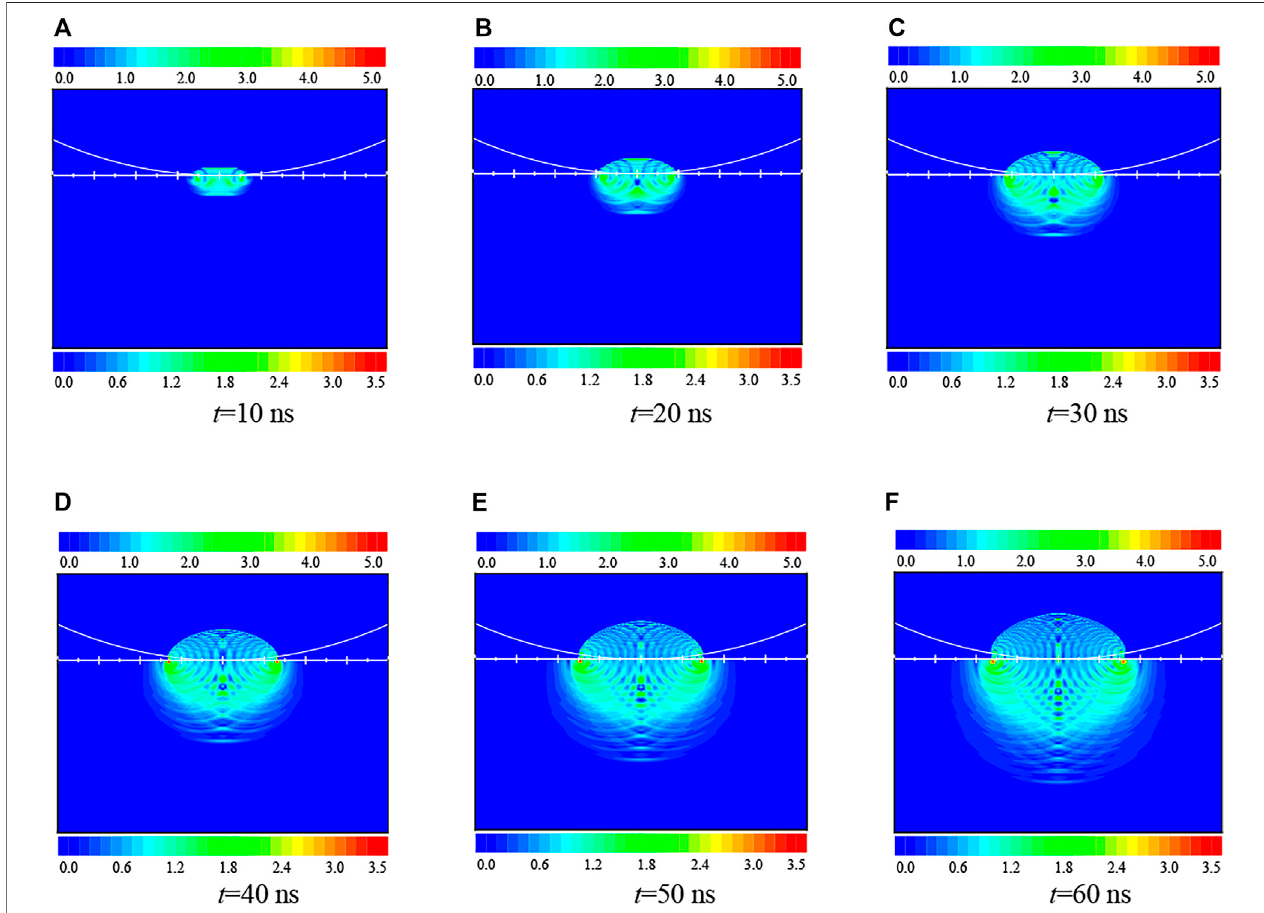
FIGURE 4 | The transient stress distribution in the solid. (A) t = 10 ns, (B) t = 20 ns, (C) t = 30 ns, (D) t = 40 ns, (E) t = 50 ns, (F) t = 60 ns.